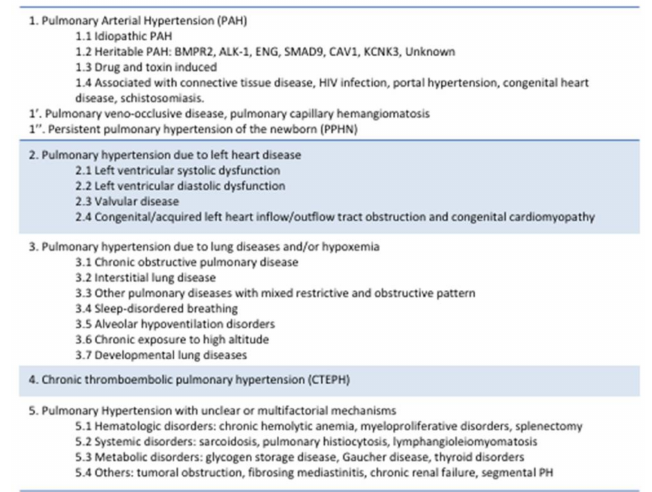
Figure 2. Updated classification of pulmonary hypertension based on recommendations from